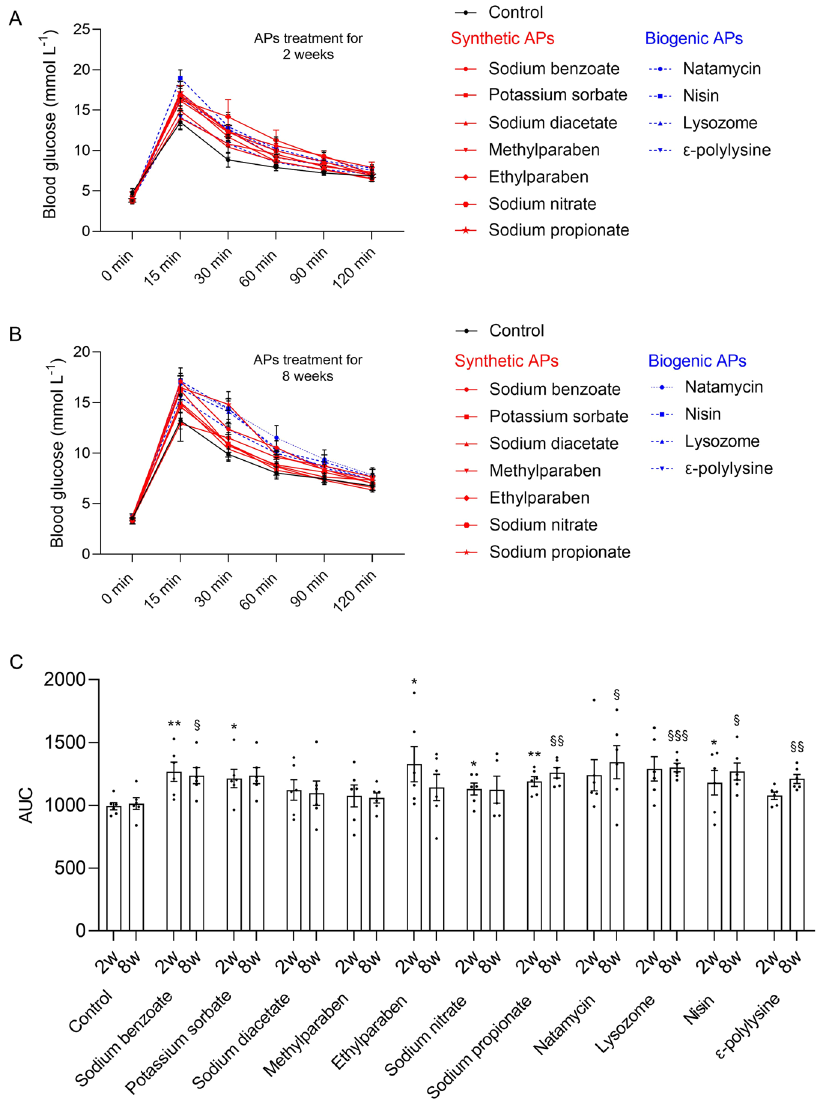
Fig. 1 Chronic APs administration induced glucose intolerance. A Oral glucose tolerance test (OGTT) after 2 weeks treatment. B OGTT after 8 weeks treatment. C The 2-h blood glucose response curve of the second week ( * P < 0.05, ** P < 0.01) and eighth week ( § P < 0.05, §§ P < 0.01, §§§ P < 0.001) , respectively. Signi fi cance was determined using two-tailed t -tests. The values are expressed as the means ± S.E.M., n = 6 per